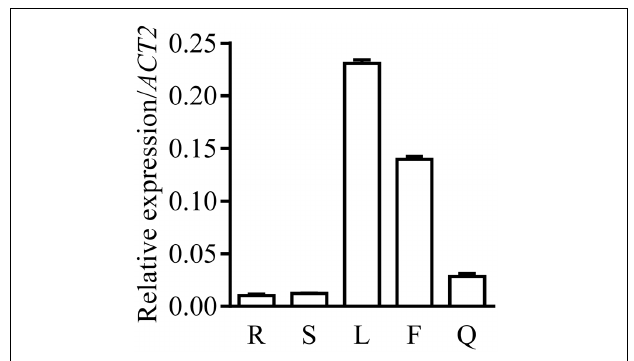
FIGURE 3 | Tissue specific expression of PSA2 in Arabidopsis thaliana . Transcript levels of PSA2 in roots (R), stems (S), rosette leaves (L), flowers (F), and siliques (Q) determined by quantitative real-time PCR are expressed relative to ACT2 ( At3g18780 ). Data represent means ± SE ( n = 6).